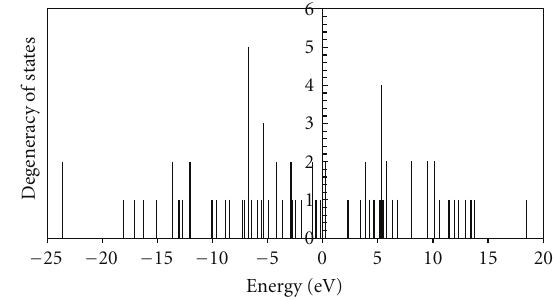
Figure 12: Degeneracy of states of surface part of Al 8 O 4 P 8 stoichiometry slab as a function of level energy. The HOMO level is taken as the reference